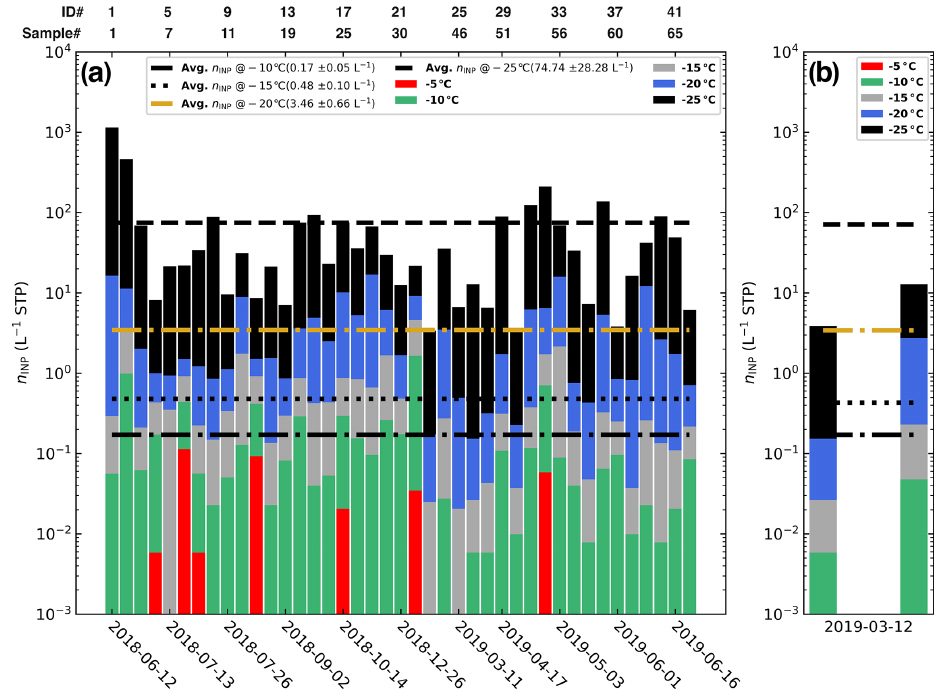
Figure 3. (a) Time series of cumulative n INP (L − 1 air) in each precipitation sample at different temperatures. (b) n INP for two precipitation samples (ID no. 26 and 27) observed on the same day of 12 March 2019. The uncertainty in the average n INP at each temperature ( ± numbers in parentheses) is the standard error calculated for 42